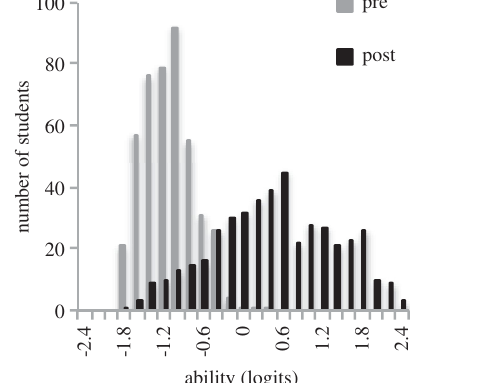
FIG. 24. The pre- and postability histograms for class 10.